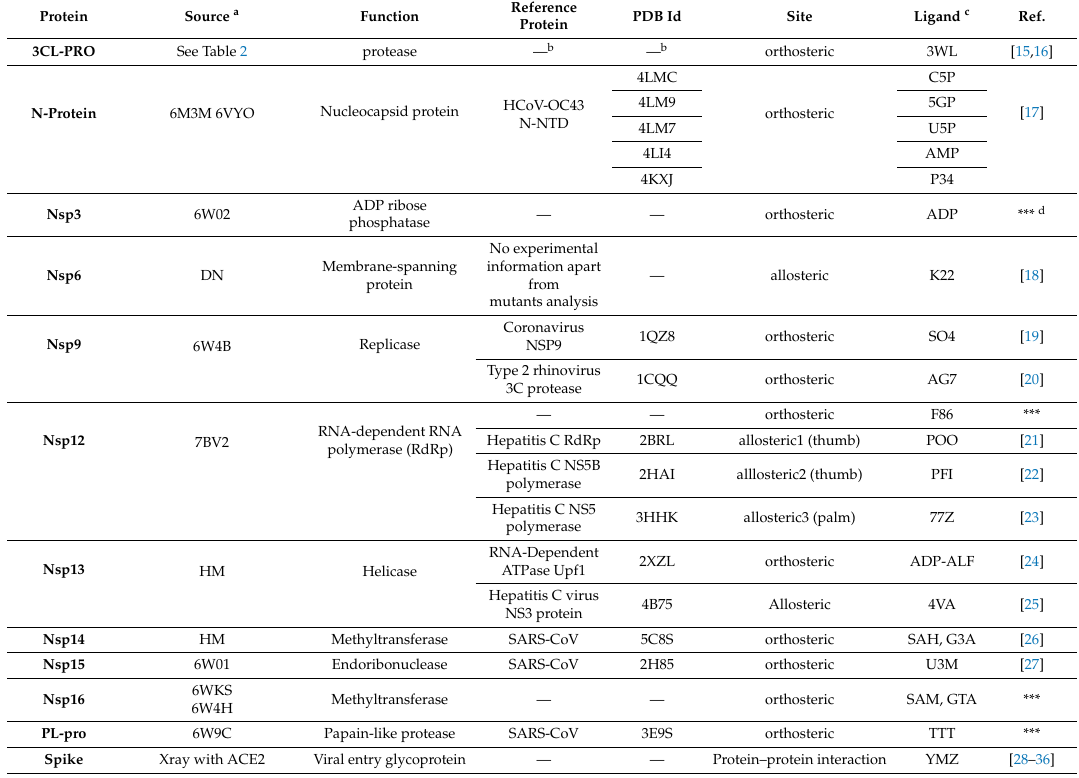
Table 1. Orthosteric and allosteric binding sites for the therapeutically relevant protein targets as derived from the literature search.